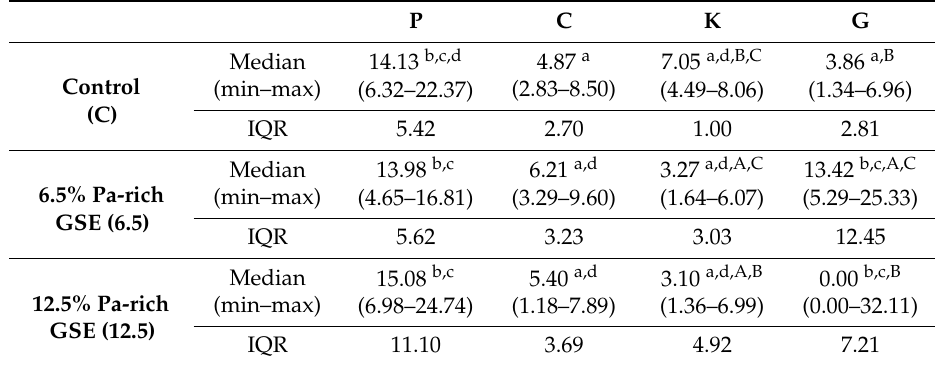
Table 2. Median, minimum (min), maximum (max) values, and interquartile ranges (IQR) of di ff erent cements with di ff erent concentrations of Pa-rich GSE.